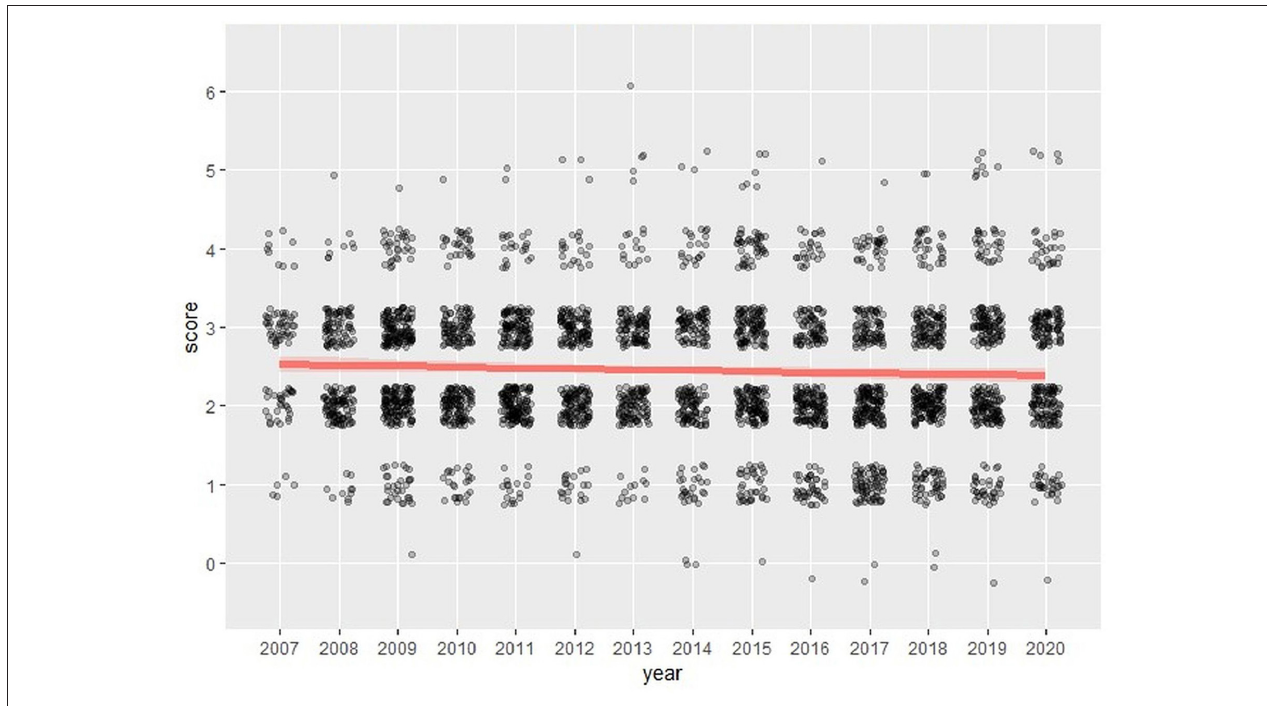
FIGURE 4 | Effect plot negative binomial regression for deconstructionalized